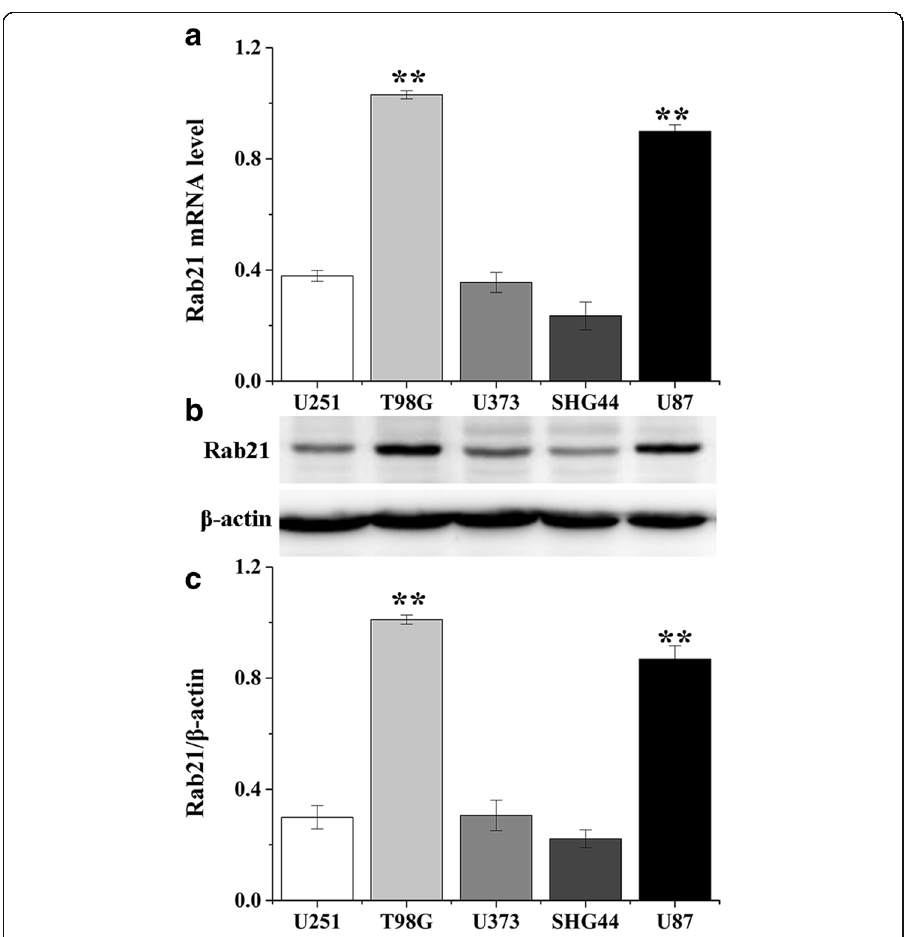
Fig. 1 Rab21 expression in human glioma cells. The mRNA ( a ) and protein ( b and c ) levels of Rab21 in five glioma cell lines were determined via qRT-PCR and western blot, respectively. **P<0.05 compared with U251 cell